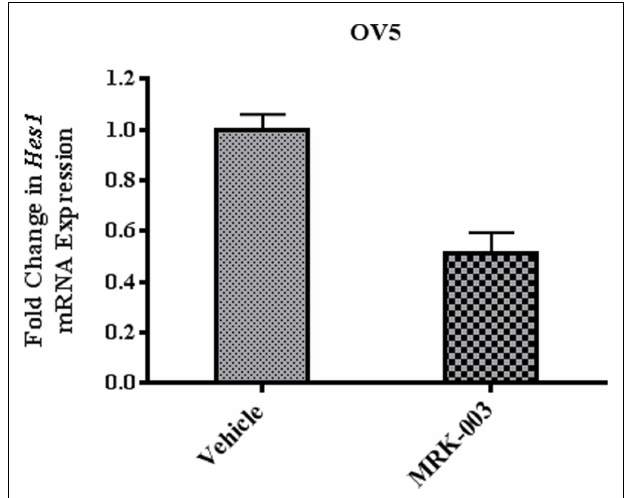
FIGURE 3 |Treatment with MRK-003 decreases Hes1 expression in vivo . qPCR analysis of Hes1 gene expression was performed using xenograft samples collected 6, 24, and 48h after treatment with MRK-003 or vehicle. Hes1 expression in OV5 xenografts collected 6h after administration of MRK-003 ( n = 2) or vehicle ( n = 2) is shown. Average relative changes in Hes1 mRNA expression were determined following normalization to β - actin expression. Error bars represent the standard error of the mean.